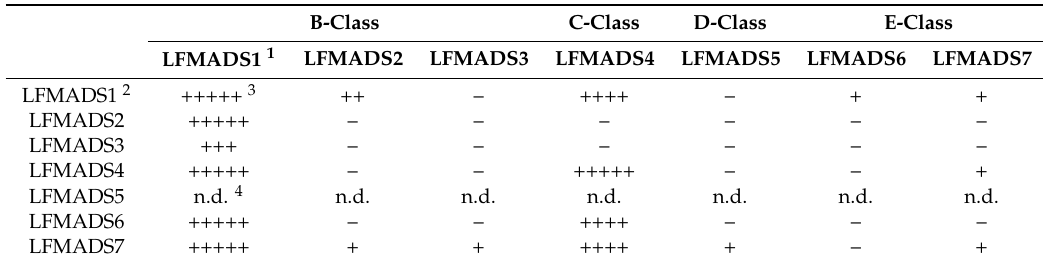
Table 4. The relationships of protein–protein interaction among B-, C-, D-, and E-class LFMADS proteins analyzed by GAL4 yeast two-hybrid